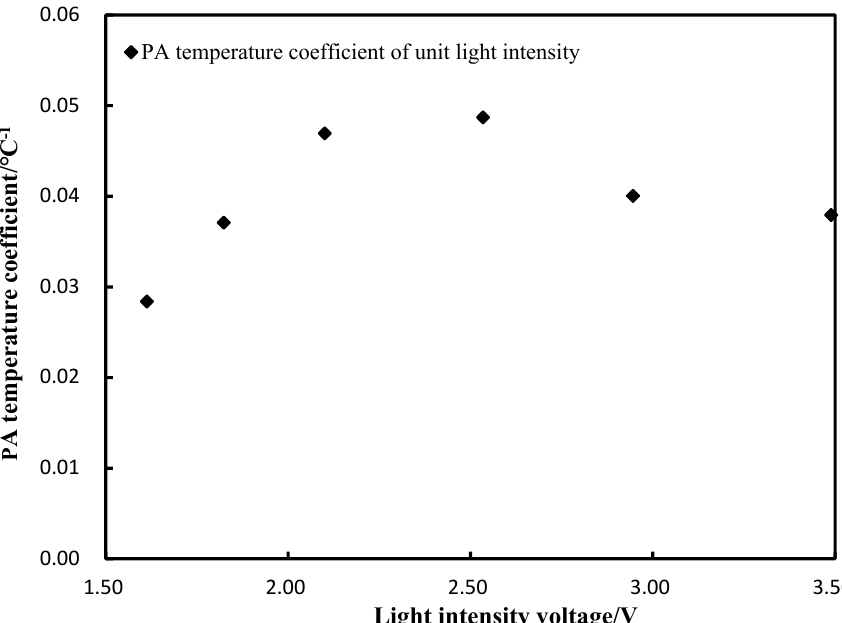
Figure 7. PA temperature coefficient of unit light intensity.